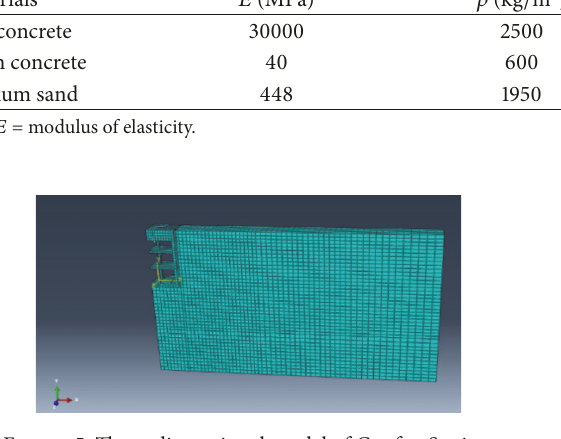
Figure 5: Three-dimensional model of Guofan Station.